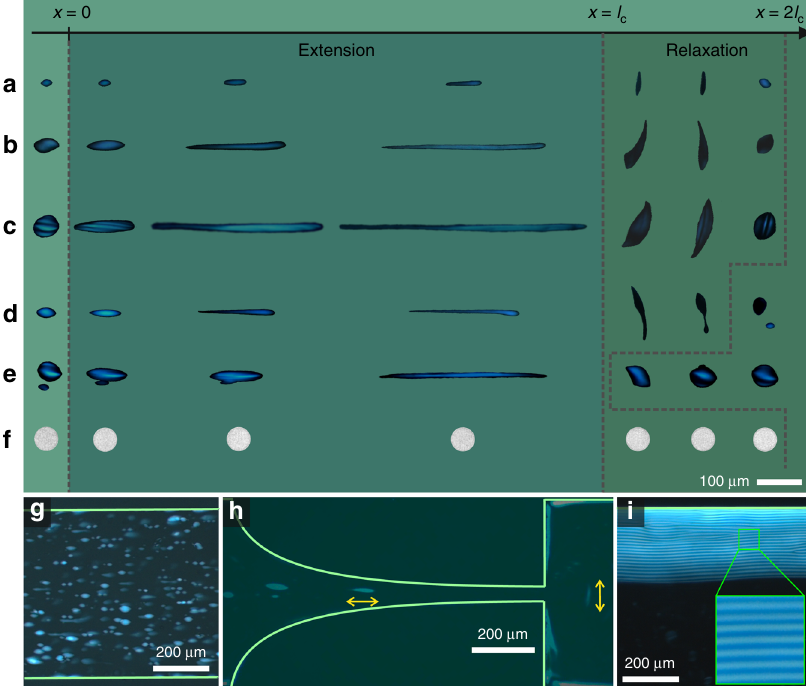
Fig. 2 Fate of amyloid fi bril tactoids under extensional fl ow fi eld. a – c The tactoids pass through the contraction zone ( fl ow direction is from left to right) while having their long axes aligned with the fl ow direction. In the contraction zone (0 < x < l c ), the homogenous tactoids maintain their original phase ( a ), while the bipolar ( b ) and cholesteric ( c ) tactoids undergo order – order transitions to homogenous tactoids. After the contraction ( l c < x ≲ 2 l c ), the tactoids rotate ~90° and recover their original phase. d Break-up of a bipolar tactoid. e Coalescence of two tactoids resulting into a tactoid with larger volume. f A control experiment on oil-in-water droplets with interfacial tension in the order of ~0.01 N m − 1 , i.e., orders of magnitudes higher than the liquid crystalline tactoids, illustrates how the oil droplet remains essentially undeformed through the same fl ow fi eld conditions used to deform the tactoids . g Alignment of the tactoids in fl ow direction. h Rotation by ~90° of the tactoids exiting the channel. i Formation of a uniform bulk cholesteric phase as large as 200 µ m with few disclination lines on the channel wall close to the exit of the channel, appeared by fl owing the suspension in the chip for more than 2